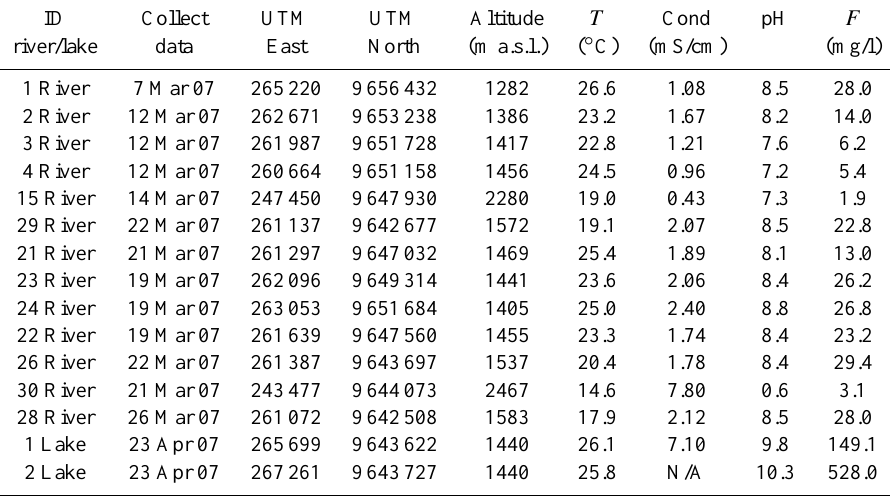
Table 2. Summary of rivers attributes.